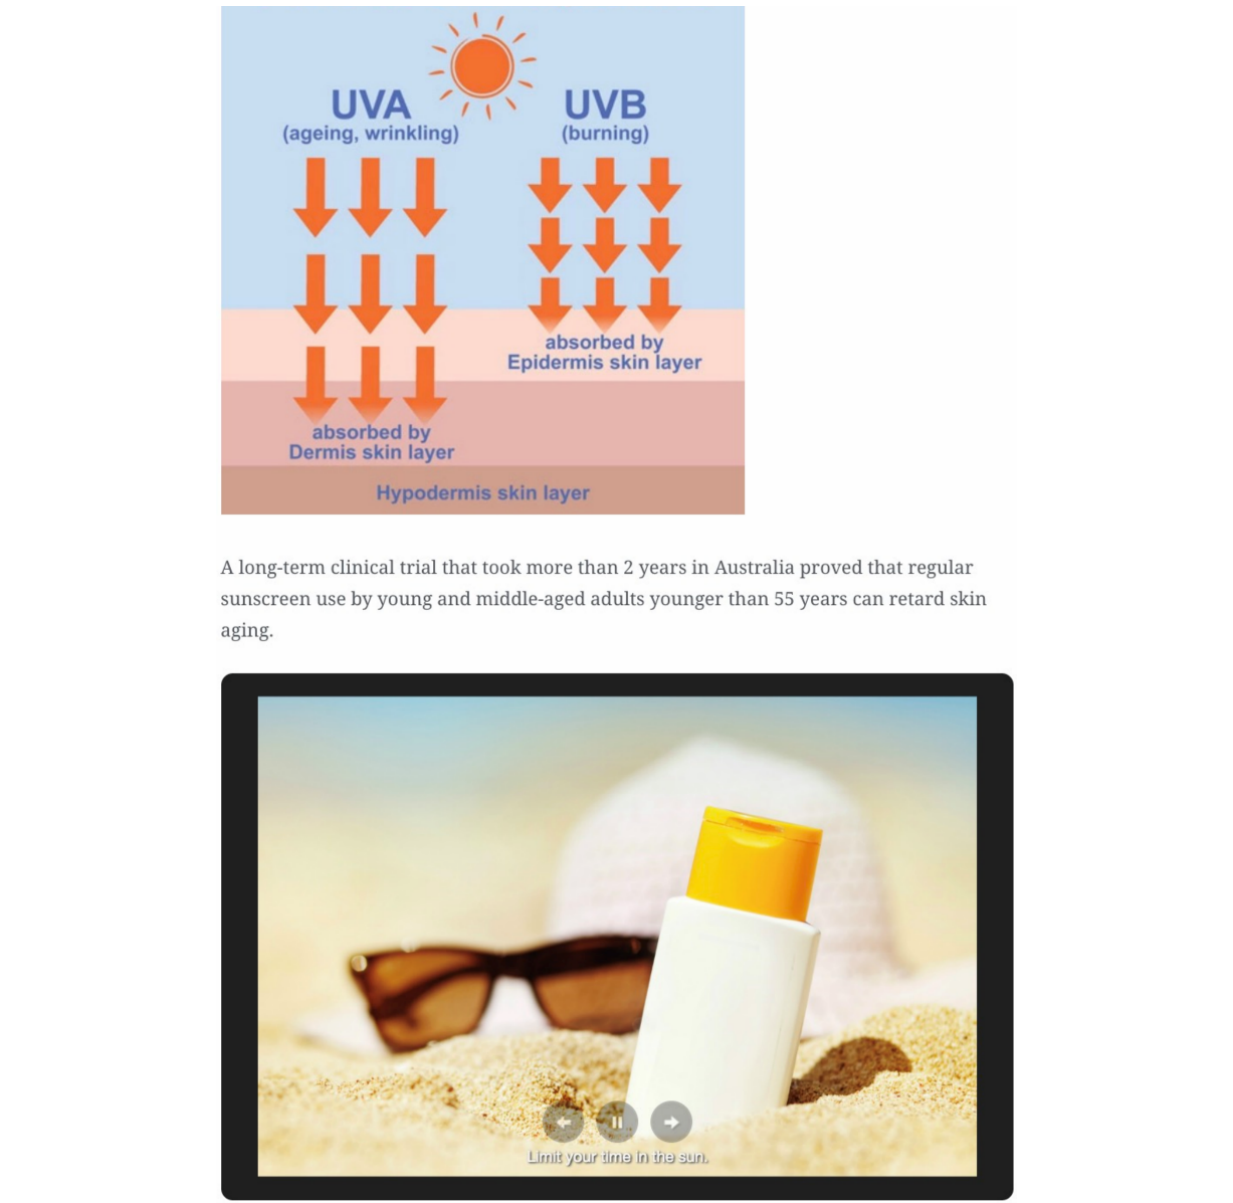
Figure 2. Screenshot of the webpage of high interactivity and human absence